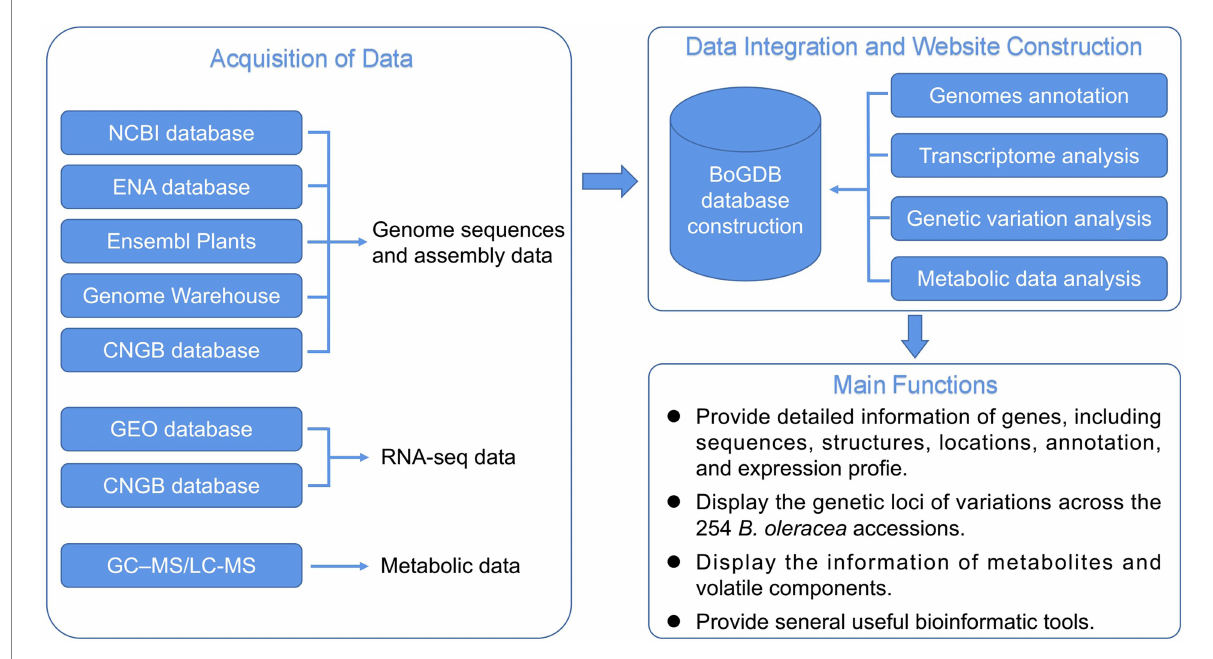
FIGURE 1 The flow diagram showing design and construction of